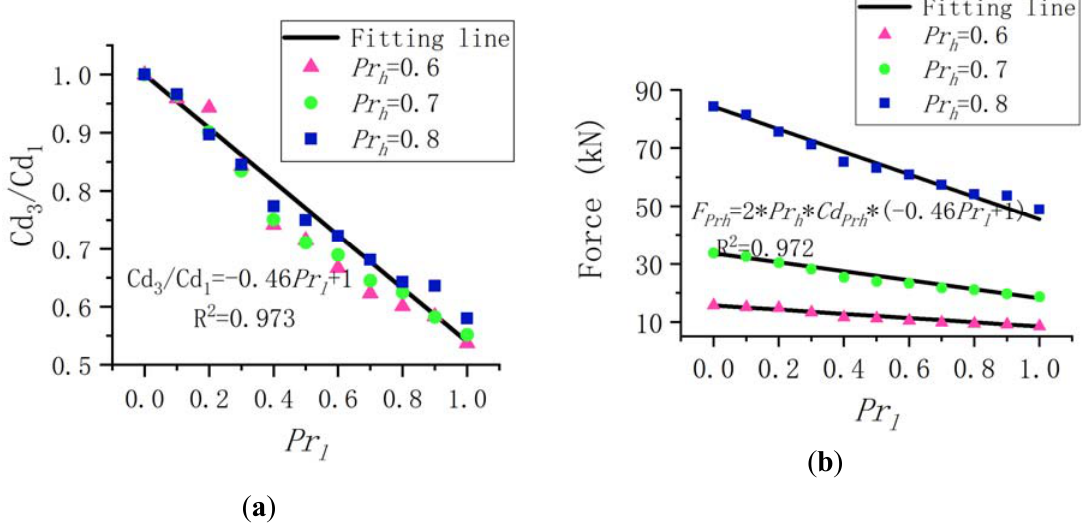
Figure 11. ( a ) Drag coefficient and ( b ) force at different inclination ratios (data sources: E1–E33).